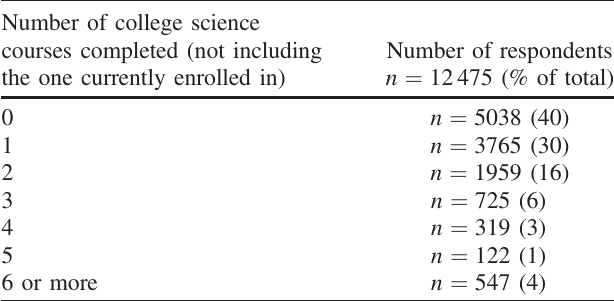
TABLE III. Number of college science courses completed.